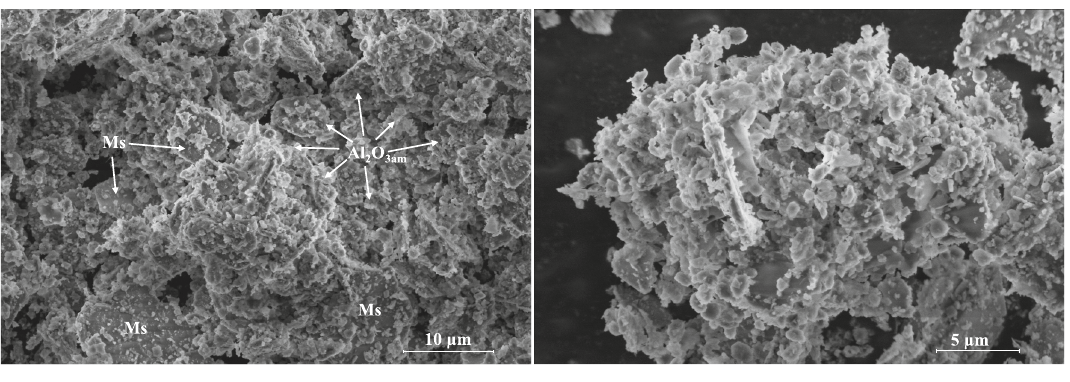
Figure 6. SEM micrographs of the sample after hydrothermal